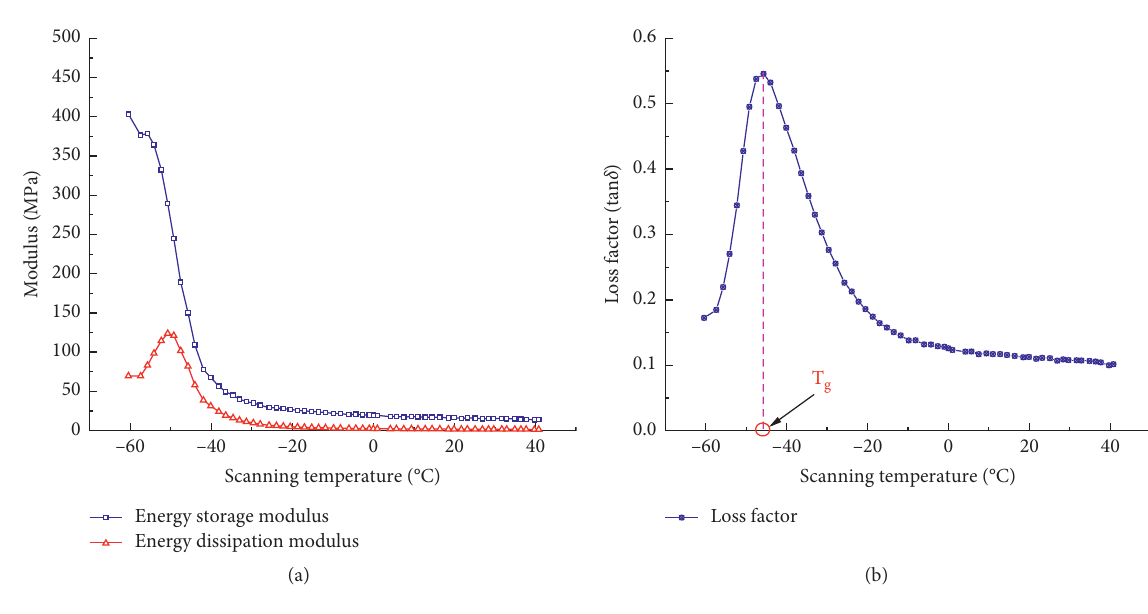
Figure 7: DMA test of rubber pad: (a) modulus; (b) loss